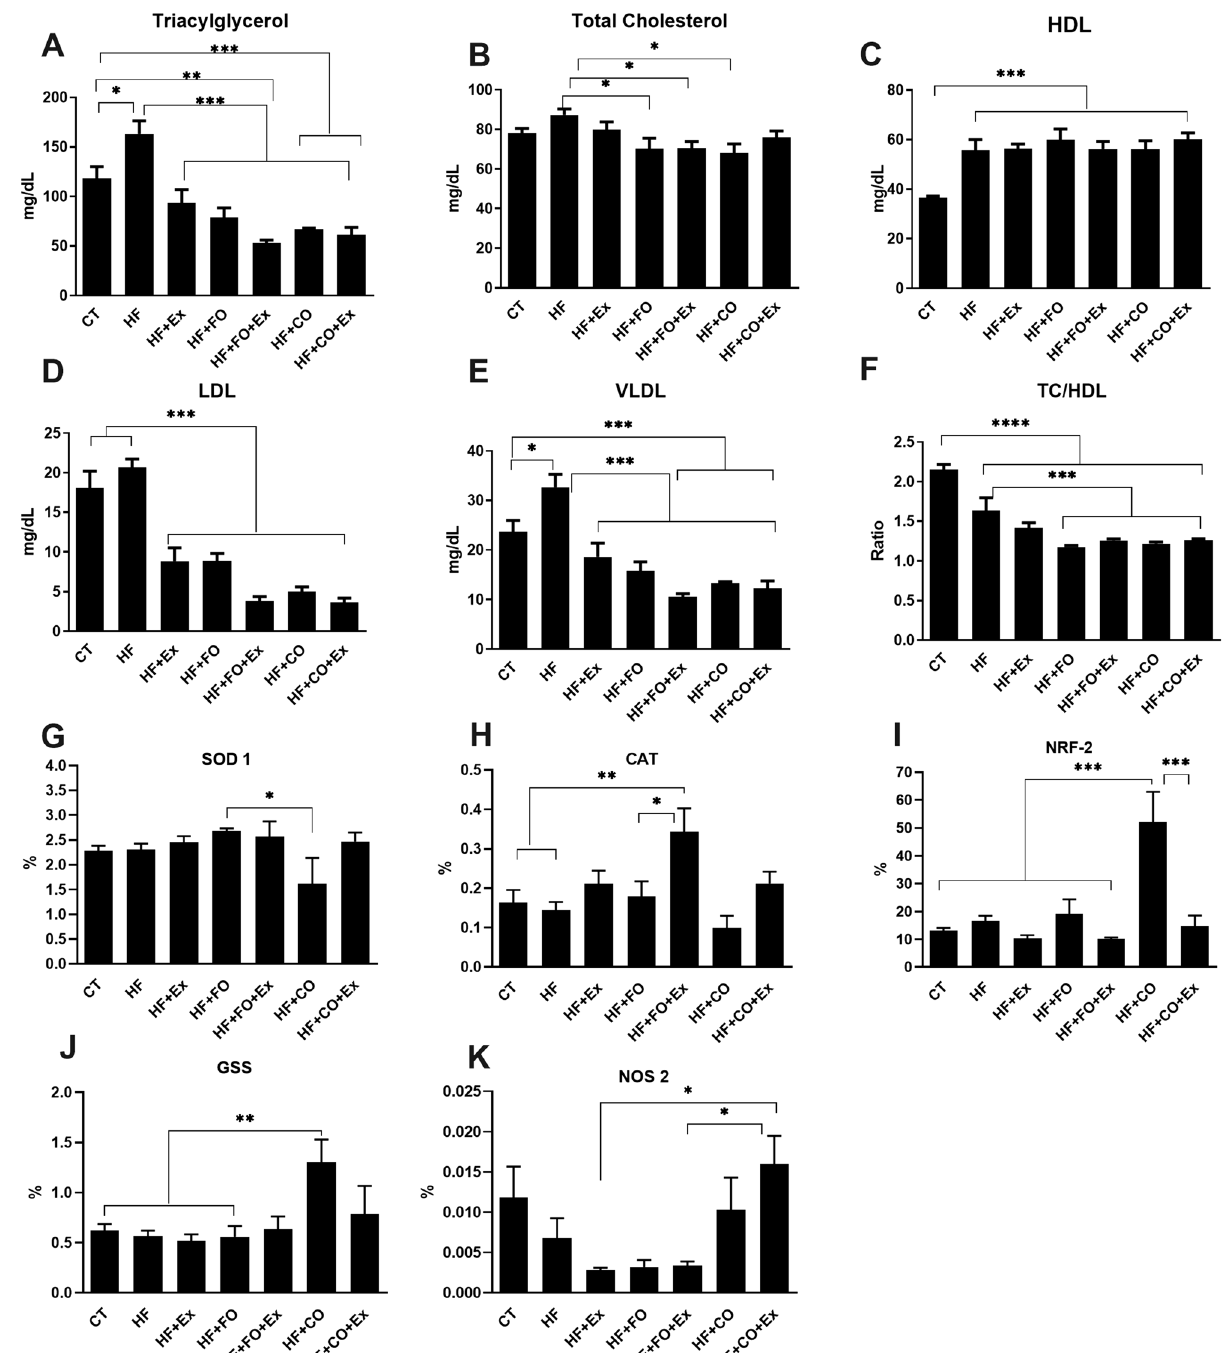
Figure 2. The significance of p < 0.05 is indicated by * and p > 0.05 ** indicating a difference between the groups. CT control, HF high-fat diet, HF + Ex high fat and aerobic exercise, HF + FO high fat and fish oil, HF + FO + Ex high fat, fish oil and aerobic exercise, HF + CO high fat and chia oil, HF + CO + Ex high fat, chia oil and aerobic exercise. ( A ) tryacilgricerol, ( B ) total cholesterol, ( C ) HDL levels, ( D ) LDL levels, ( E ) VLDL levels, ( F ) TC/HDL levels, ( G ) amount of the superoxide dismutase gene (SOD-1) in the ventral prostate; ( H ) amount of catalase (CAT) in the ventral prostate; ( I ) amount of NRF-2 in the ventral prostate; ( J ) amount of glutathione (GSS) in the ventral prostate; ( K ) amount of nitric oxide synthase 2 (NOS-2) in the ventral prostate. The Two- Way ANOVA test was used to compare the means, with the Tukey